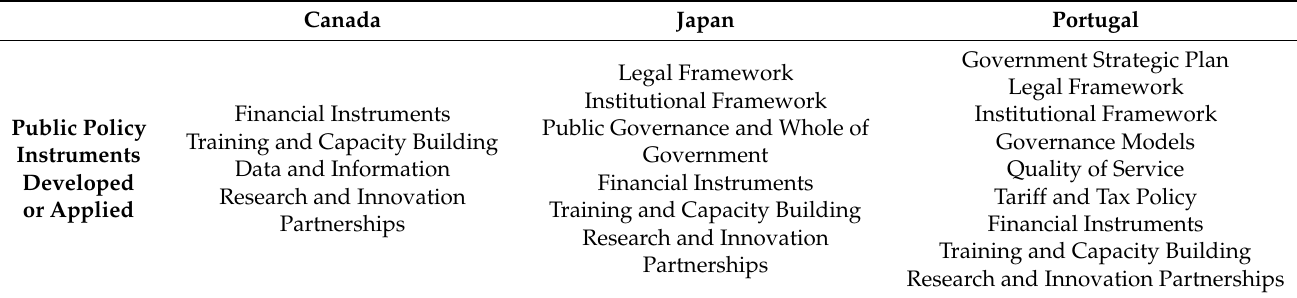
Table 9. Case study public policy